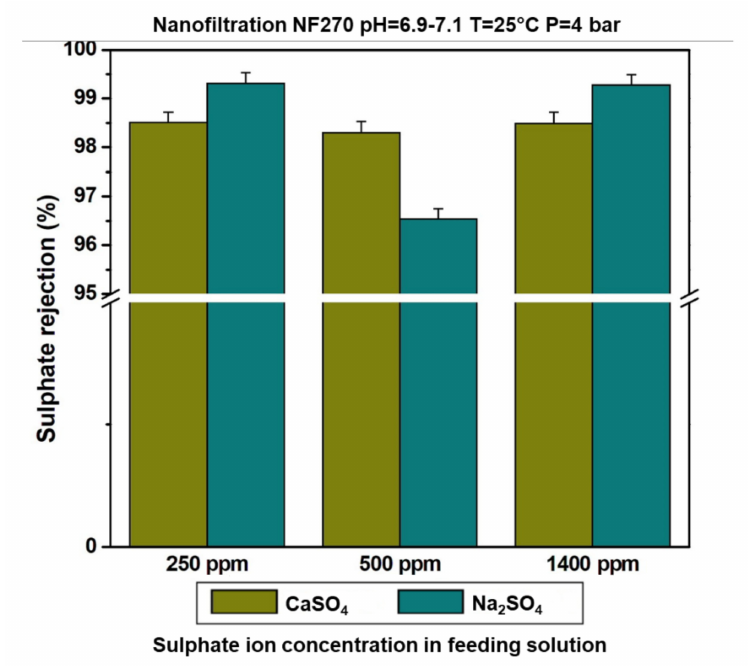
Figure 6. Counter ion effect on sulphate ion rejection with the nanofiltration NF270 membrane.